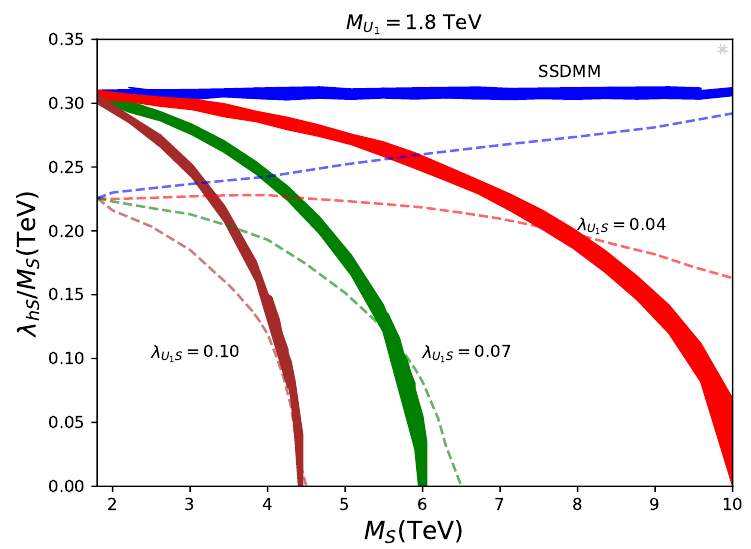
Figure 3 . Value of λ hS /M S (TeV) required to reproduce the relic density in the SSDMM (blue) and in the modified SSDMM with λ = 0 . 10 (brown), 0.07 (green) and 0.04 (red), for M U 1 S all as a function of M . Dashed lines indicate the future limits from indirect detection searches by S CTA